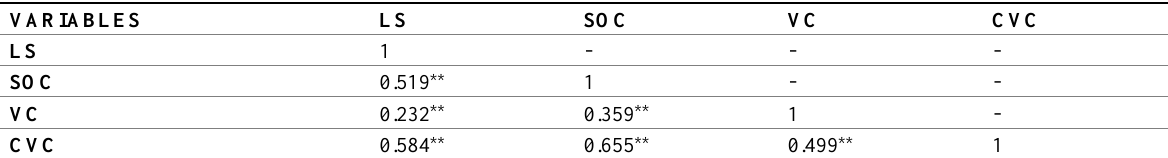
Table 6: Correlation Matrix